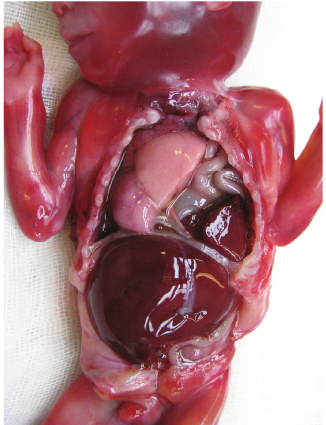
Figure 1: Anatomical postmortem exam of the fetus showing short nose with flat nasal bridge.